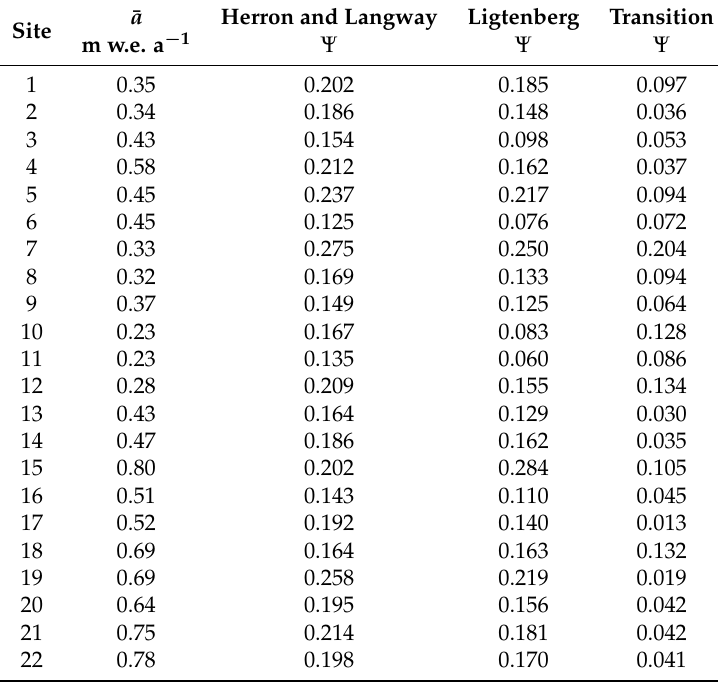
Table 1. Cost functions over the range of 500–600 kg m − 3 for the Herron and Langway, Ligtenberg, and transition models for sites in the Pine Island Glacier